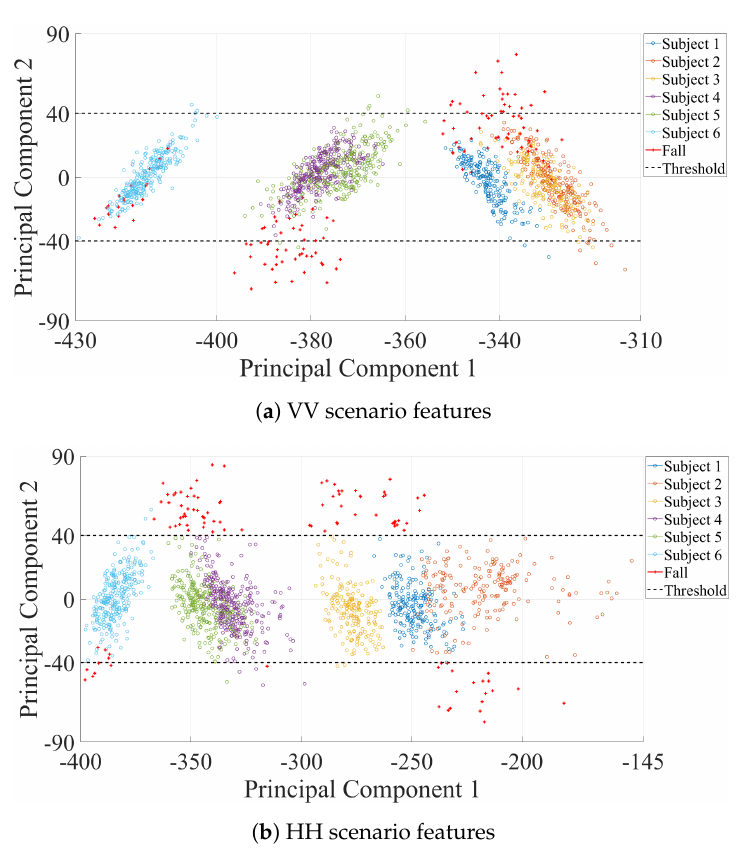
Figure 10. Projection of the first and second principal